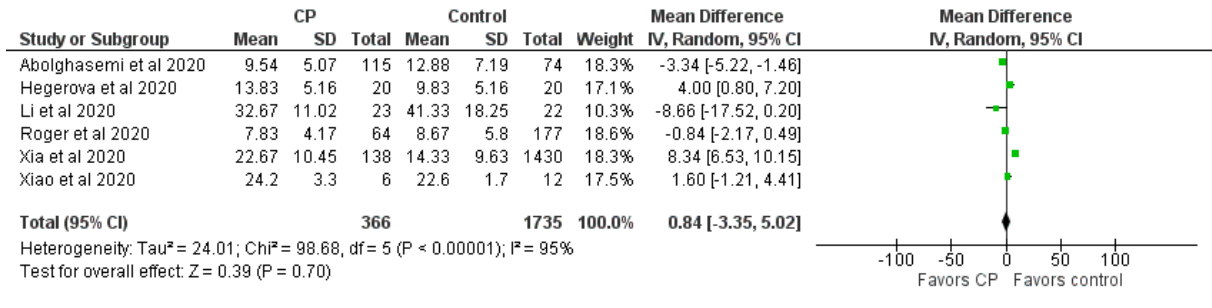
Figure 3. Efficacy of CP treatment on length of hospital stay in COVID-19 patients. Data from 6 controlled clinical trials were pooled using an inverse variance method and analyzed using a random-effects model. Means and SDs were the statistical measures used to describe the length of hospital stay. CP: convalescent plasma.